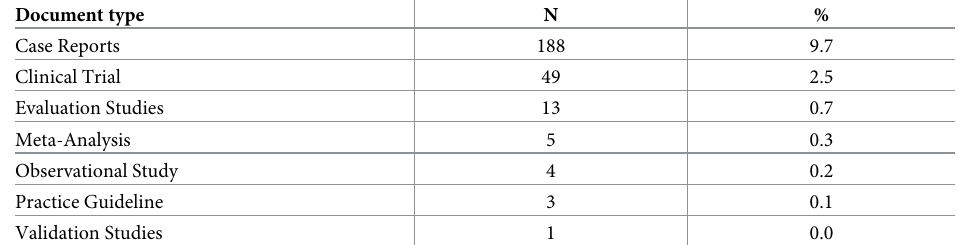
Table 1. Distribution of the document types by clinical interest, as assigned under the Chagas cardiomyopathy descriptor in MEDLINE.